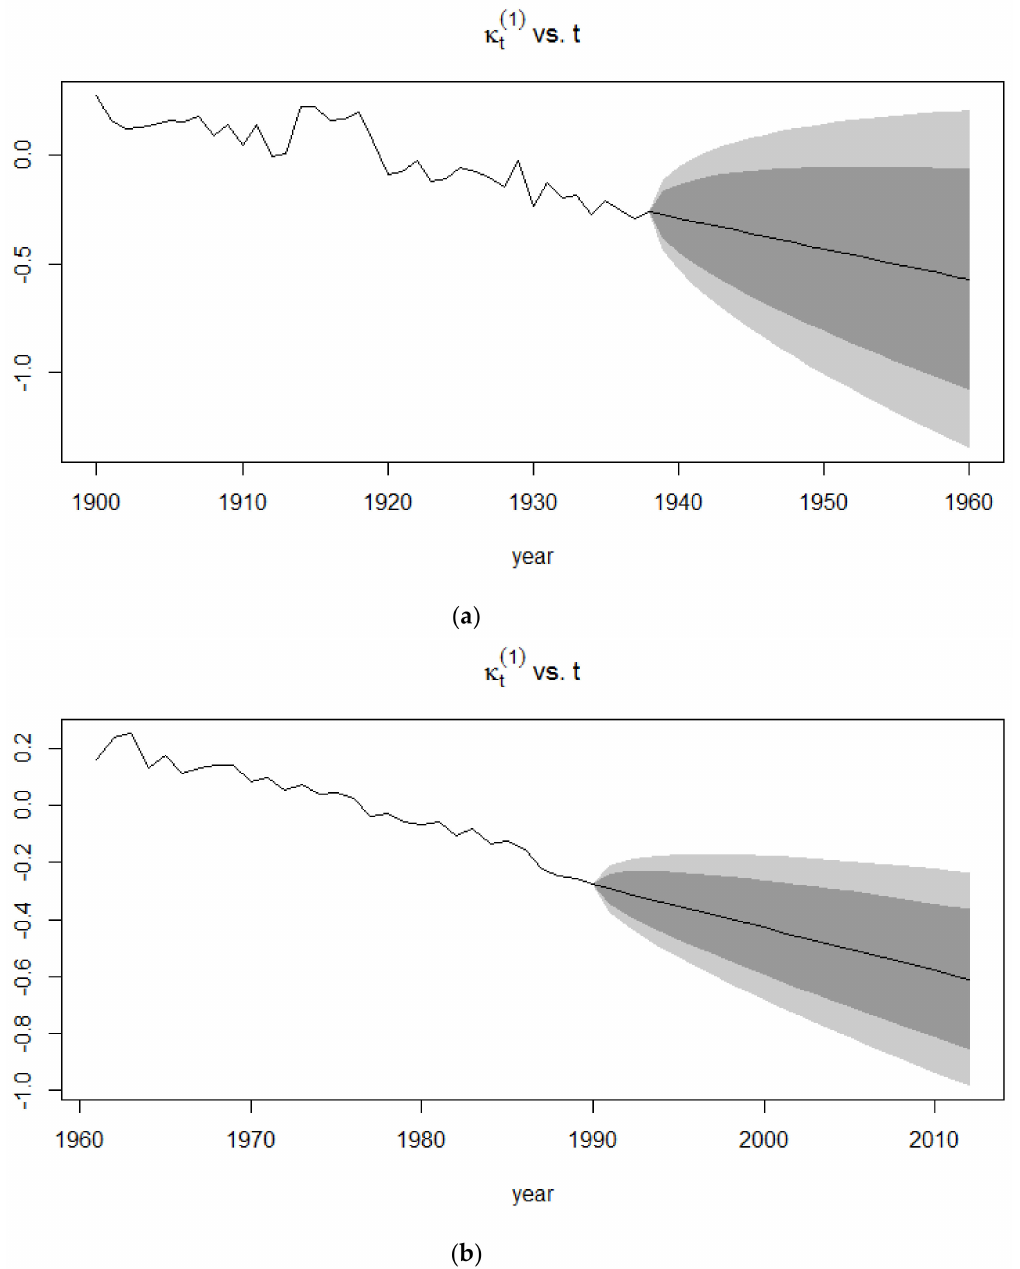
Figure 7. The forecast of the mortality index using the APC model for the ( a ) 1939–1960 period and ( b ) 1991–2015